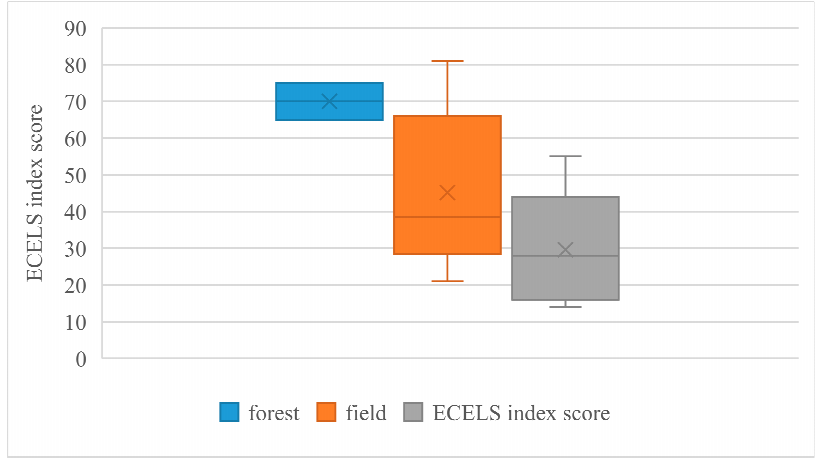
Figure 3. ECELS index score for ponds according to land use. Table 2. The value of ECELS components for ponds according to land use.